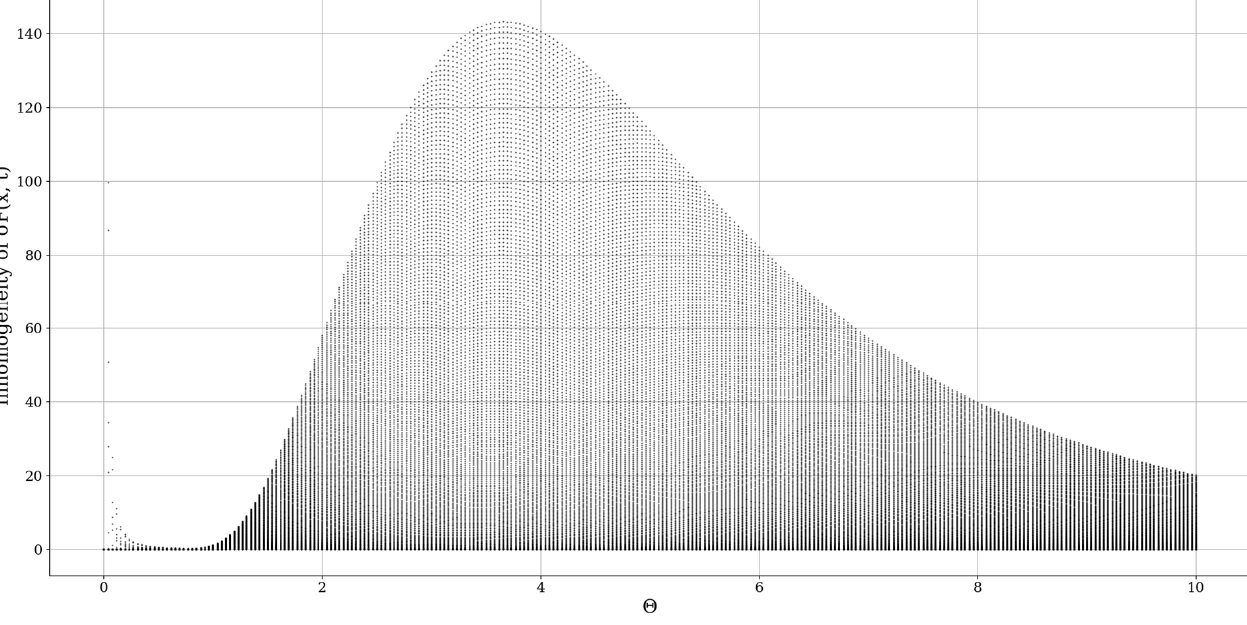
Figure 7. 〈|σ (cid:2890) (cid:3364)(cid:3364)(cid:3364)| (cid:4593)(cid:2870) 〉 example plot with θ as control parameter; ξ = 6 ; μ = 1 .